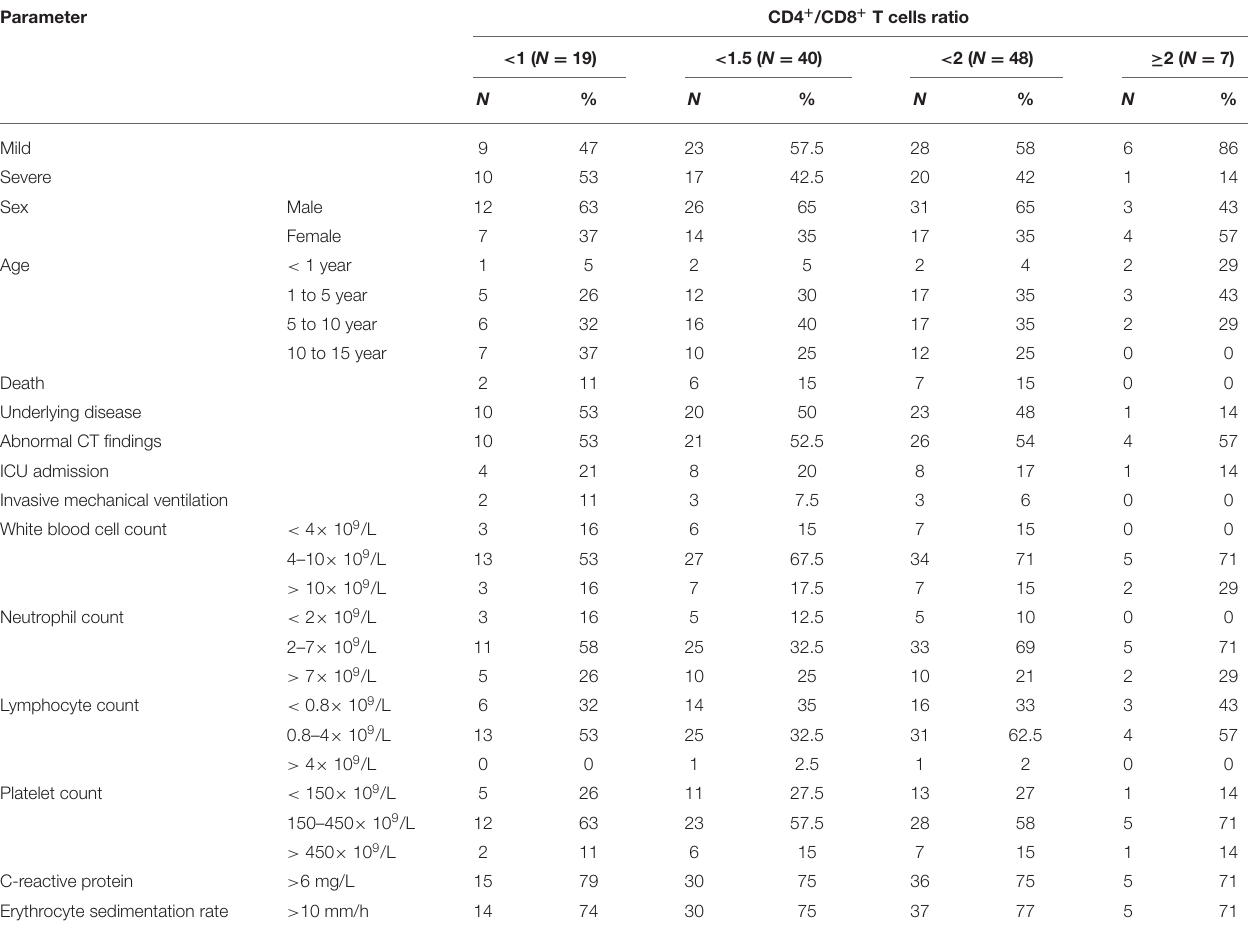
TABLE 3 | Demographic and laboratory findings of children with COVID-19 according to different CD4 + /CD8 + T cells ratio. Parameter